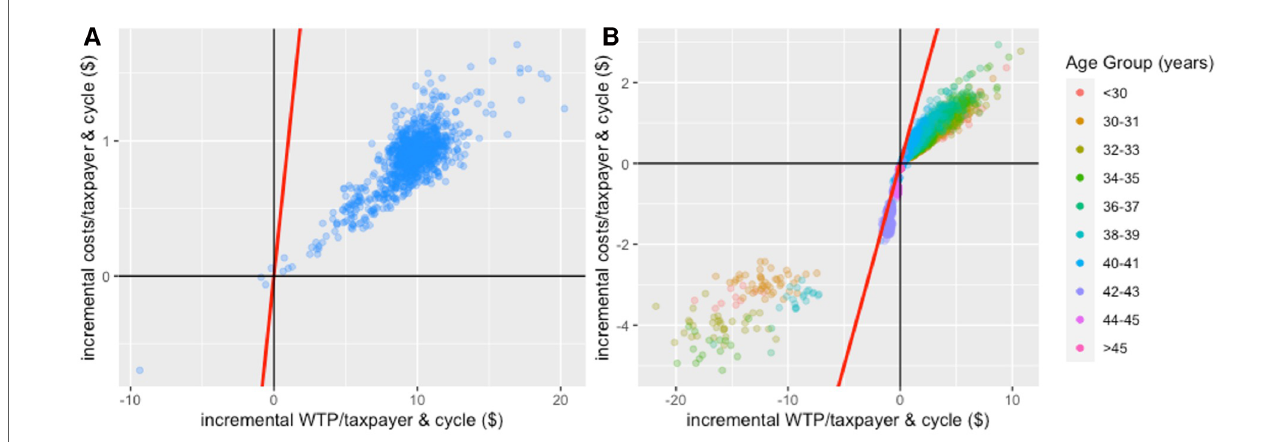
FIGURE 6 Cost-bene fi t planes for IVF treatment comparing the intervention package of fertility treatment (i.e., only funding cost-bene fi cial treatment cycles) to the current package of fertility treatment (comparator) based on the analysis that only considers costs and bene fi ts of women reaching OPU. Panel ( A ): cost- bene fi t plane for the aggregated analysis; Panel ( B ): cost-bene fi t plane for the age-strati fi ed analysis. The red line indicates points of indifference (i.e., where incremental costs equal incremental bene fi ts). In Panel ( B ), 1.51% of observations are to the left of the red line in the lower left quadrant: 1.0% of observations in <30-year-old women; 4.4% in 30 – 31-year-old women; 3.2% in 32 – 33-year-old women; 1.5% in 34 – 35-year-old women; 0.3% in 36 – 37- year-old women; 1.9% in 38 – 39-year-old women; 0.6% in 40 – 41-year-old women; 2.2% in 42 – 43-year-old women; 0% in 44 – 45-year-old women; 0% in >45-year-old women. These points indicate observations where the current package of fertility treatment would be preferred over the policy intervention package. It is due to a limitation of our approach and Supplementary Appendix C provides a more detailed